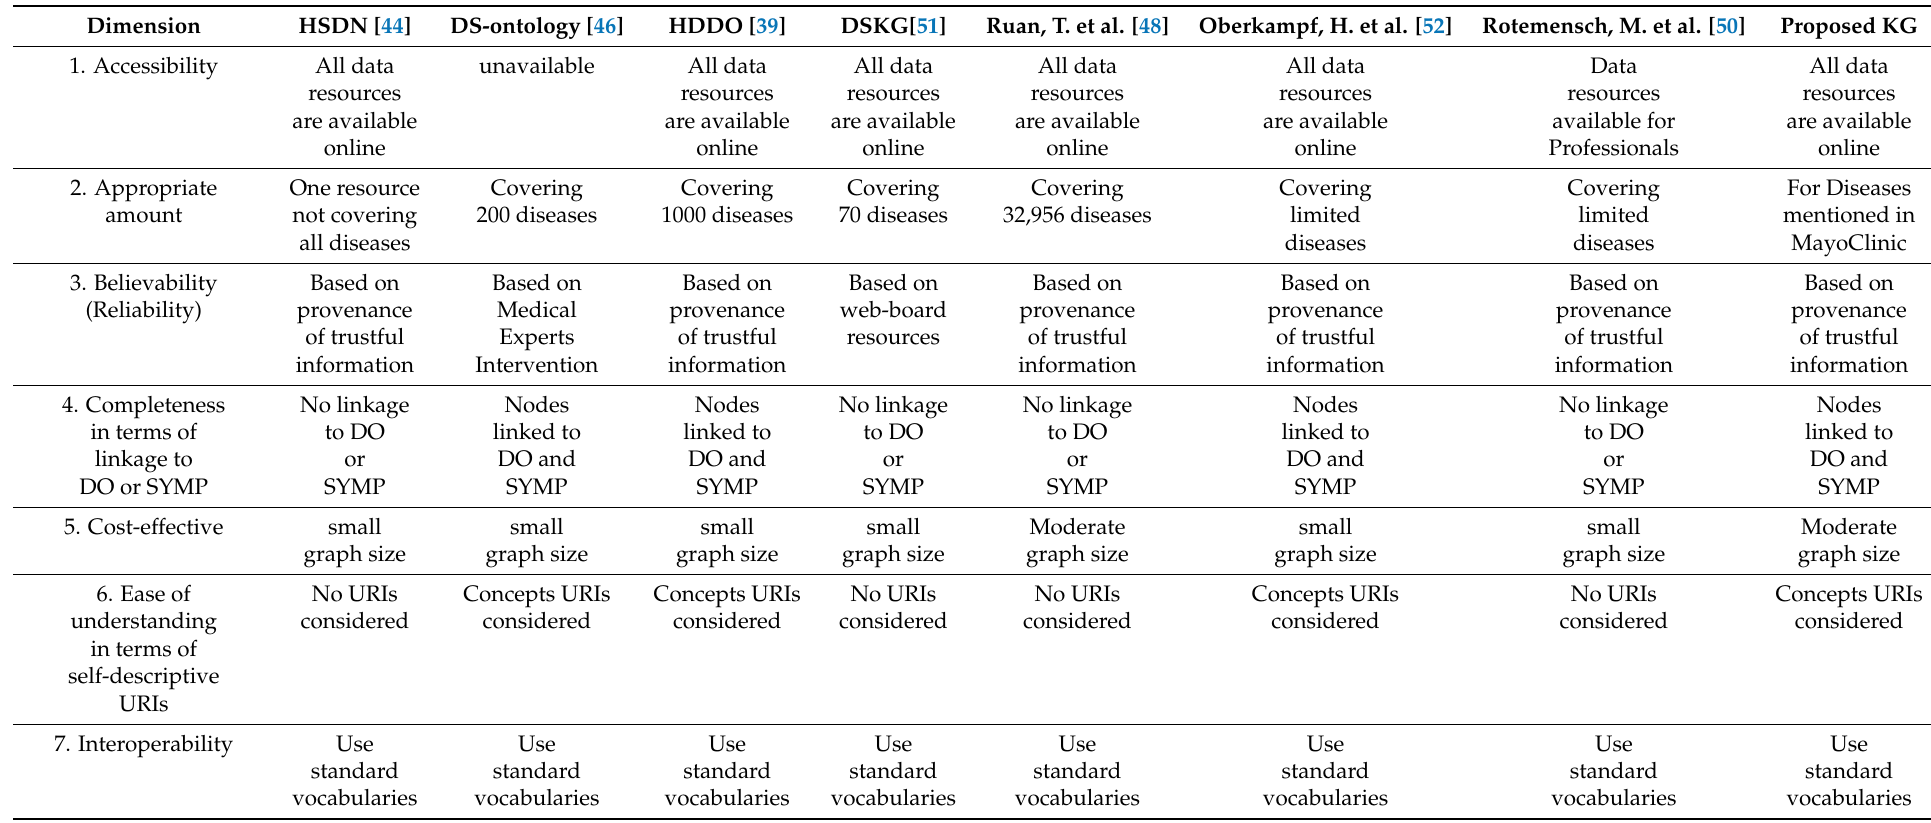
Table 4. Quality dimensions-based comparison between different studies generated